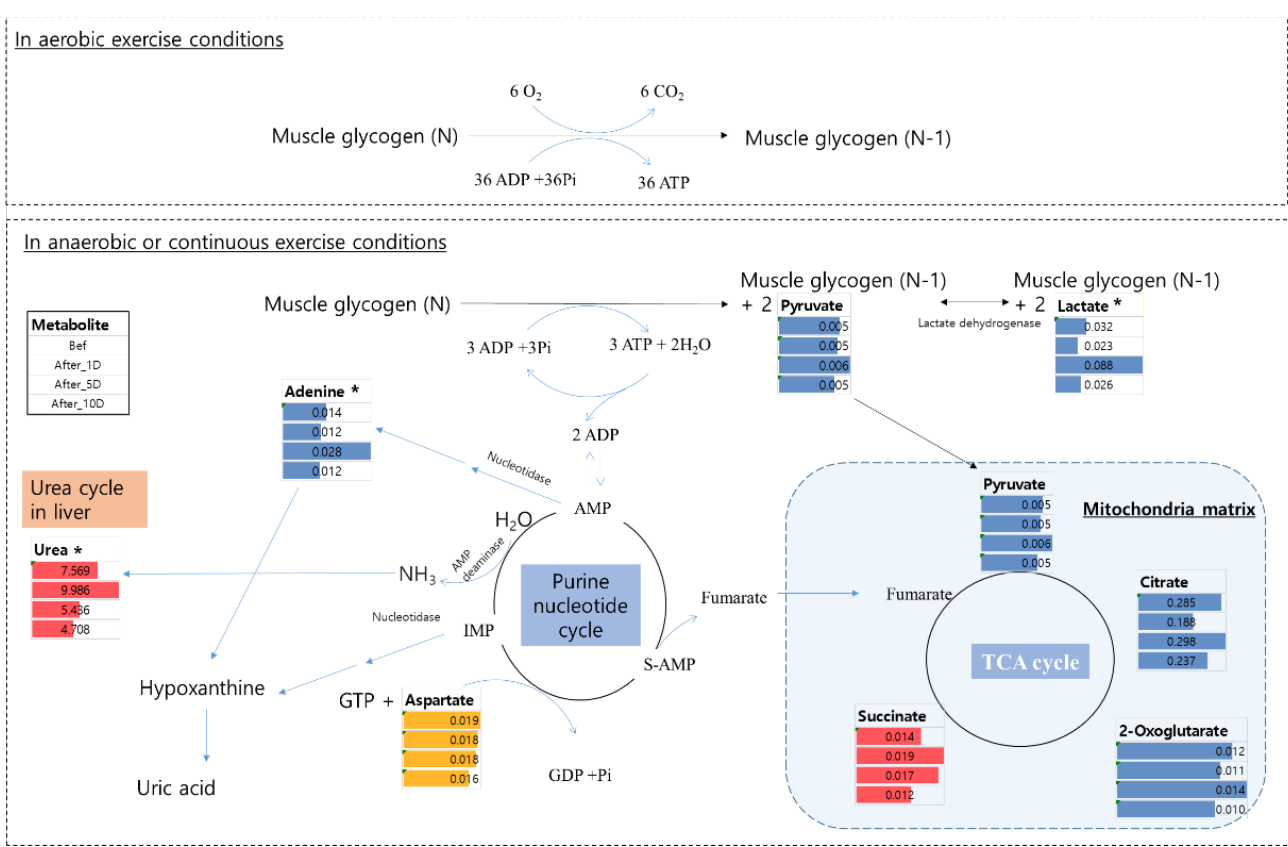
Figure 3. Metabolic change of potential biomarkers in aerobic and anaerobic (or continuous) condi- tions. * means significantly different metabolite compared to before WTS. Bef: before WTS; Af- ter_1D: 1 day after WTS; After_5D: 5 days after WTS; After_10D: 10 days after WTS.